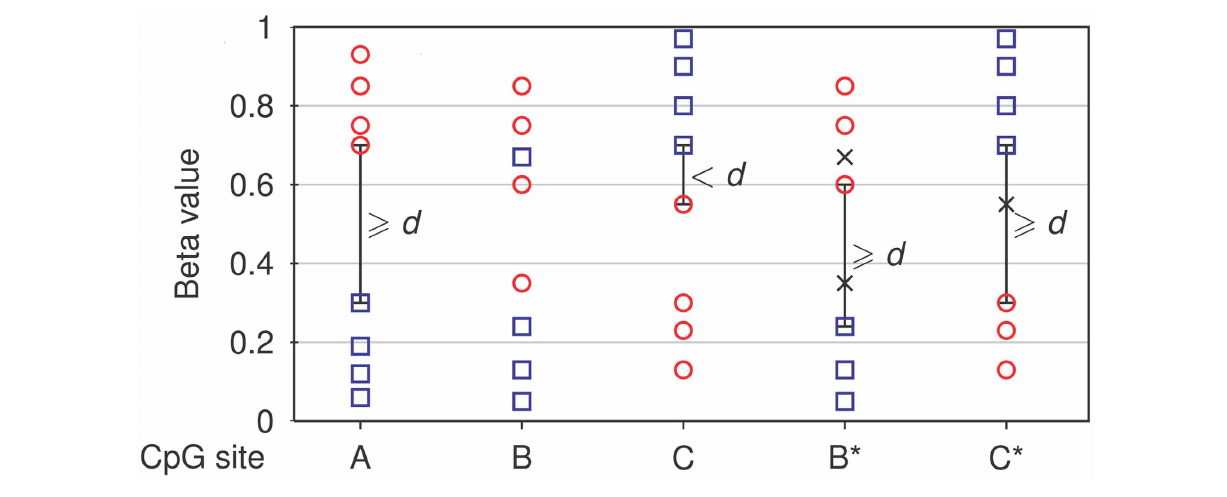
sites separated by at least a value of d are identified (A) . If samples are masked (marked as x), sites with previously overlapping groups (B) or low discrimination (C) are additionally identified and flagged (B ∗ ,C ∗ )